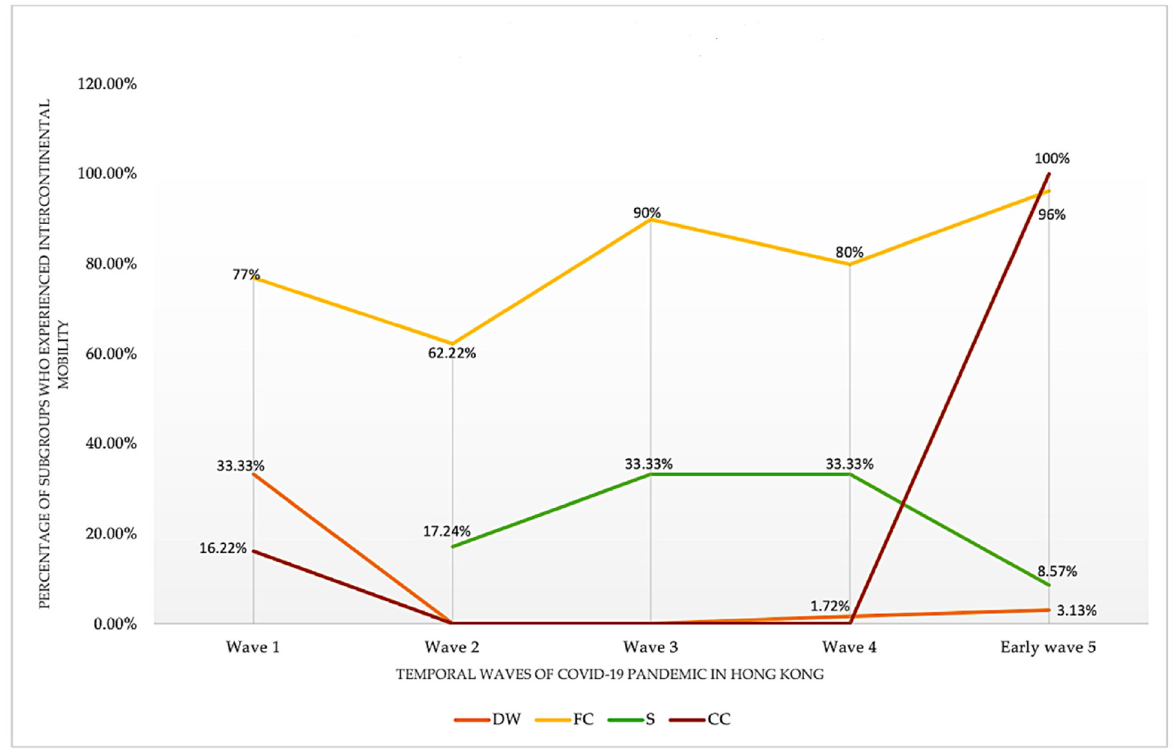
Figure 6. Study Population’s Temporal Intercontinental Mobility (America, Europe, Africa and Oceania).